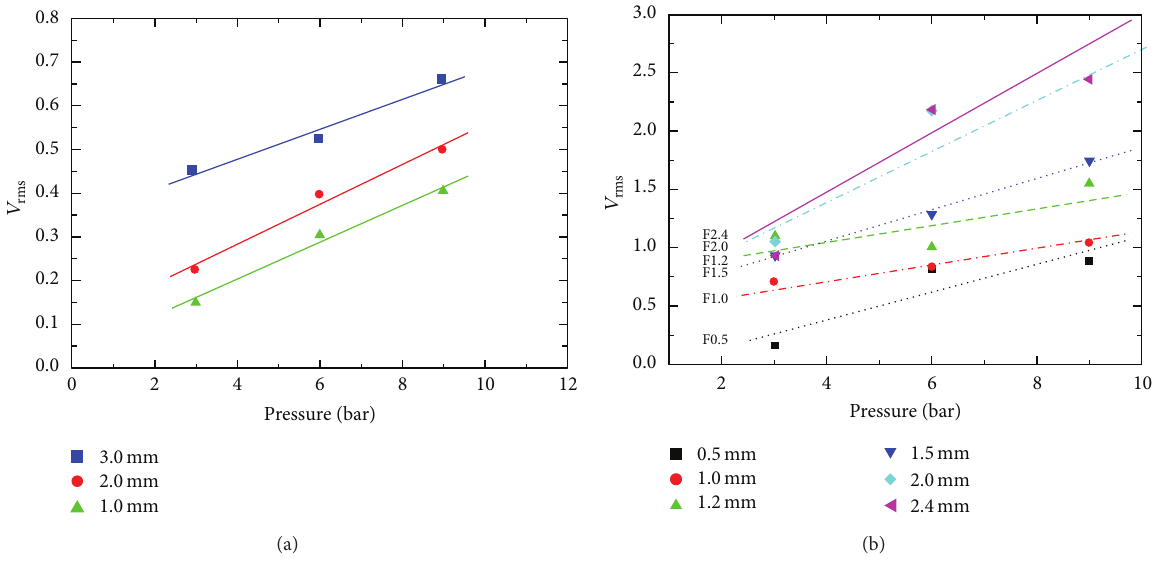
Figure 6: RMS values of the acoustic signals: (a) disk wear and (b) foreign objects [70].